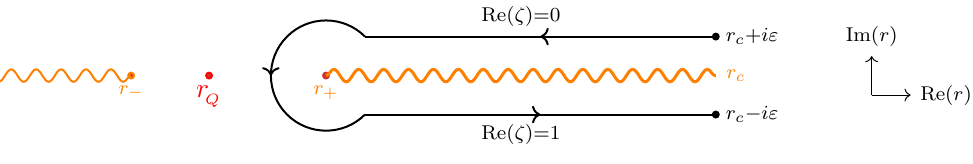
Figure 1 . The complex r plane with the locations of the two regulated boundaries (with cut-off r c ), the outer and inner horizons at r ± and the ohmic radius r marked. The grSK contour is a Q codimension-1 surface in this plane (drawn at fixed v ). As indicated the direction of the contour is counter-clockwise, and it encircles the branch point at the outer horizon with the cut running out to the boundary. The cut emanating from the inner horizon and the ohmic radius, are not encountered by the